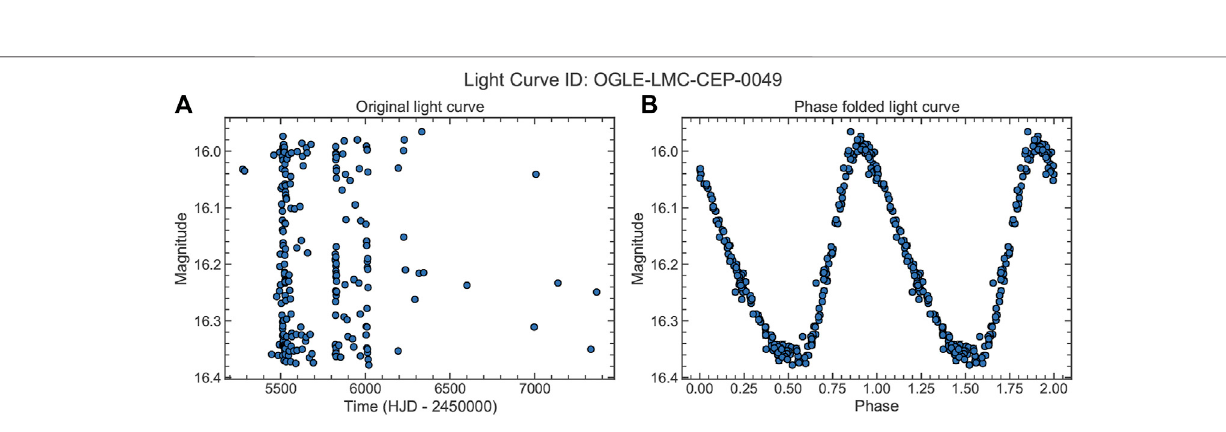
FIGURE 2 | Light curve for a classical Cepheid from the OGLE survey. (A) shows the original light curve whereas (B) shows the phase-folded light curve with an estimated period of 3.8497 days. The light curve id is mentioned as the title of the